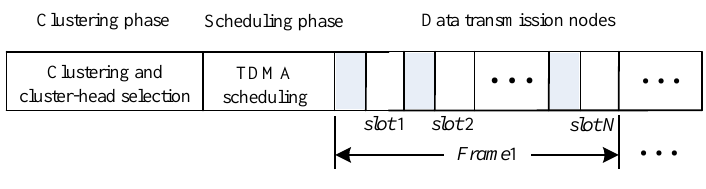
Figure 4. Time slot diagram of a TDMA frame